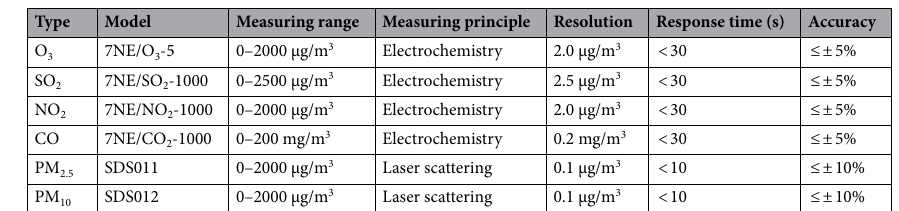
Table 1. Detailed parameters of the atmospheric sensor.